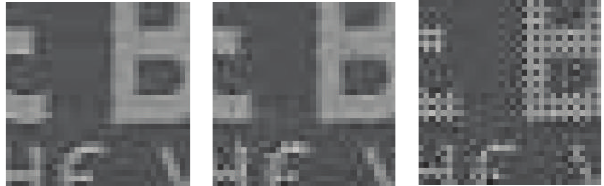
Figure 11: Original data (left), reconstruction using proposed method (middle), and reconstruction using bilinear Interpolation